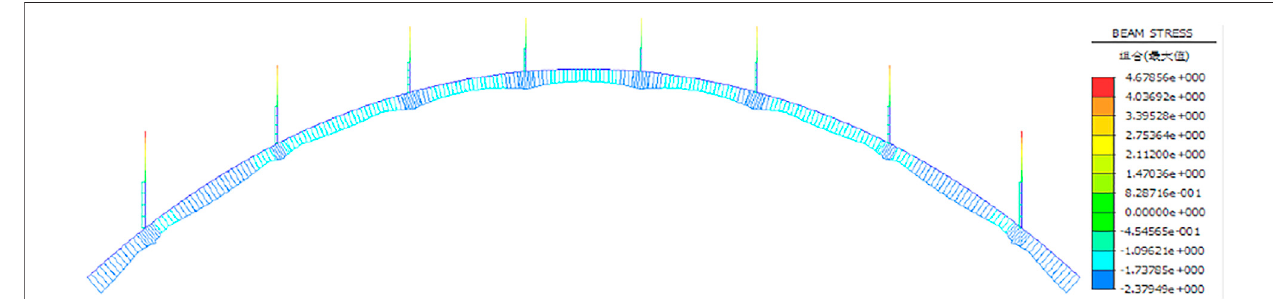
FIGURE 3 | Stress nephogram of the arch model.